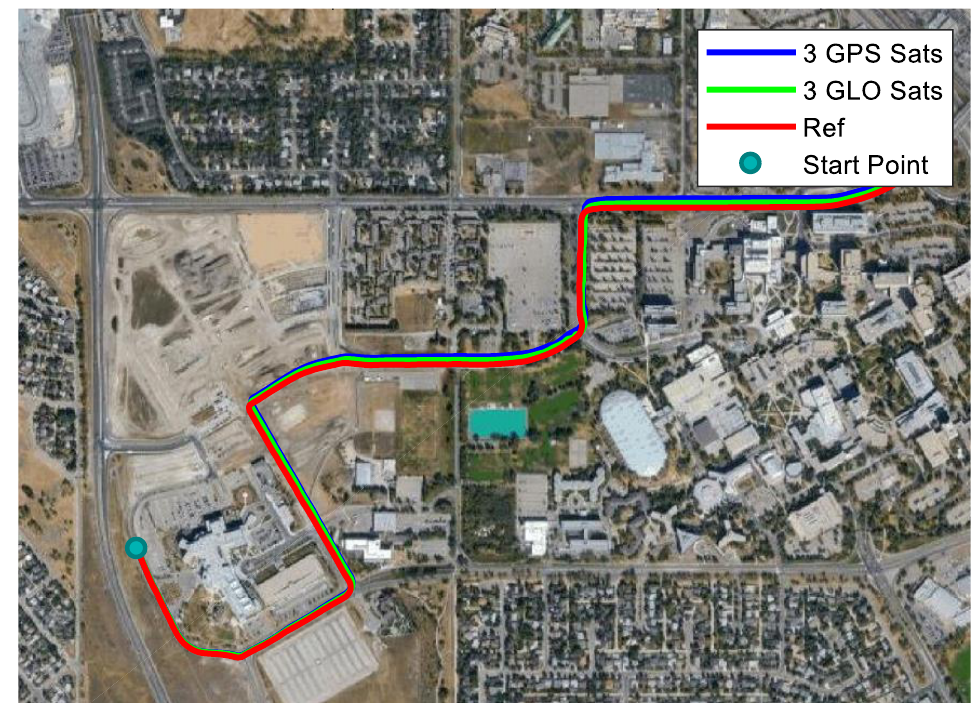
Figure 6. Trajectories of using GPS and GLONASS with similar geometric distributions.